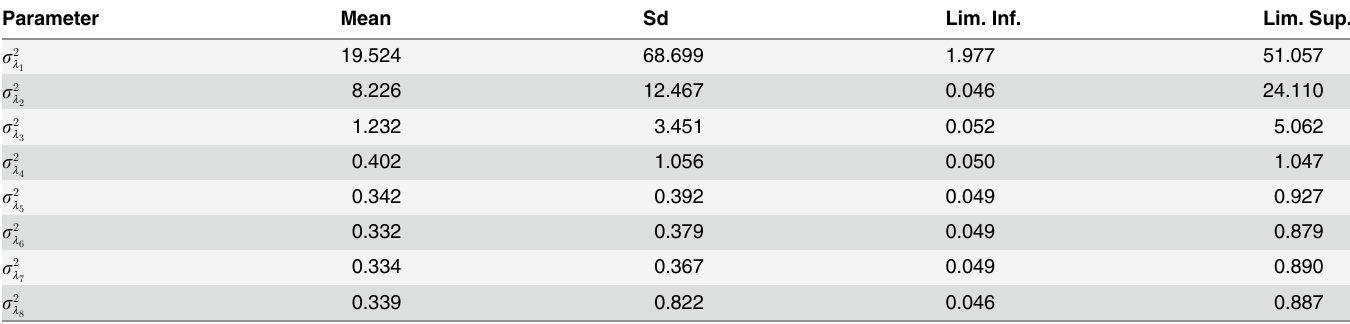
Table 2. Posterior mean estimates and the 95% credible interval (CI) for the variance components of the singular values. Parameter Mean Sd Lim. Inf. Lim.